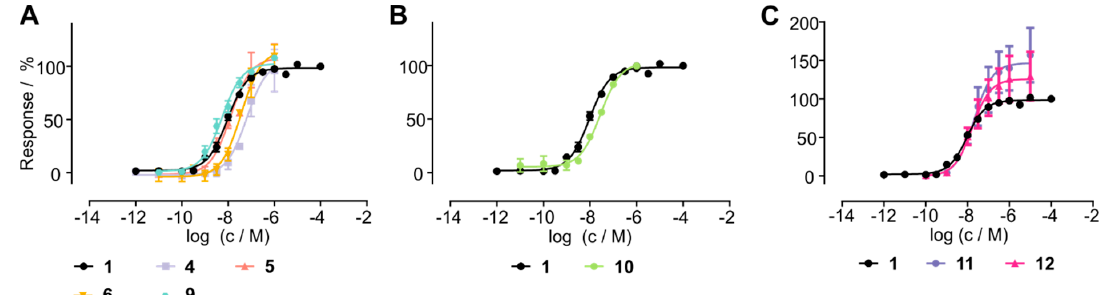
Figure 4. Activity of cyclic chemerin-9 derivatives tested in a Ca 2+ flux assay. ( A ) Influence of different side chain cyclization on activity, whereas cyclization through D-Hcys 4 and Cys 9 yields the most active peptide 9 . ( B ) N-Terminal stabilization by a D-Tyr preserves activity of the cyclic peptide 10 . ( C ) N-Terminal attachment of either an EG(4) linker ( 11 ) or a GFLG linker ( 12 ) does not impact activity. All data points represent mean ± SEM of at least two independent experiments performed in triplicates. Table 4. Activity of chemerin-9 derivatives. All data were obtained from at least two independent experiments performed in triplicates (Ca 2+ flux) or quadruplicates (arrestin recruitment). Data were normalized to the top and bottom values of the chemerin-9 curve, and nonlinear regression was performed with a three-parameter curve fit in GraphPad Prism 5. X = Homocysteine, x = D-homcys-